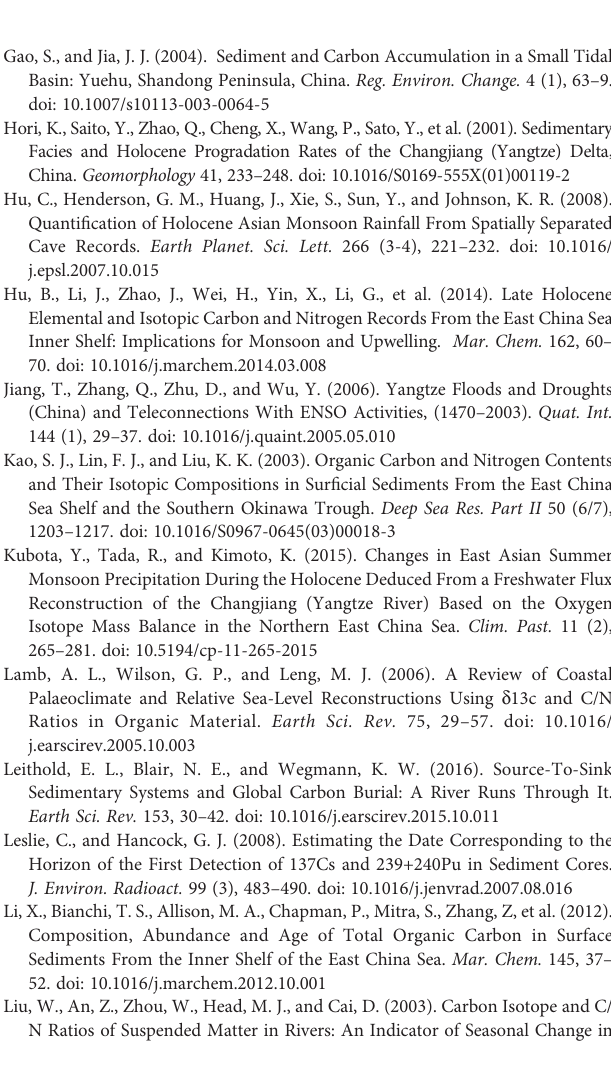
Supplementary Figure 1 | Pro fi les of (A) 137Cs and (B) 210Pb activity. (C) Age – depth model for the sediment sequence of core C2. Supplementary Figure 2 | The vertical distribution of trace metals (Li, Ti, Ni, Zr, Ho, Mo, Th, Sr) and Ca/Al in the core C2. Supplementary Figure 3 | UCC-normalized patterns of REE in the four periods of C2 (UCC data was source from McLennan, 2001). Supplementary Figure 4 | The linear correlation between Zr VS Ca (A) , Sr VS Ca (B) , Ti VS Ca (C)